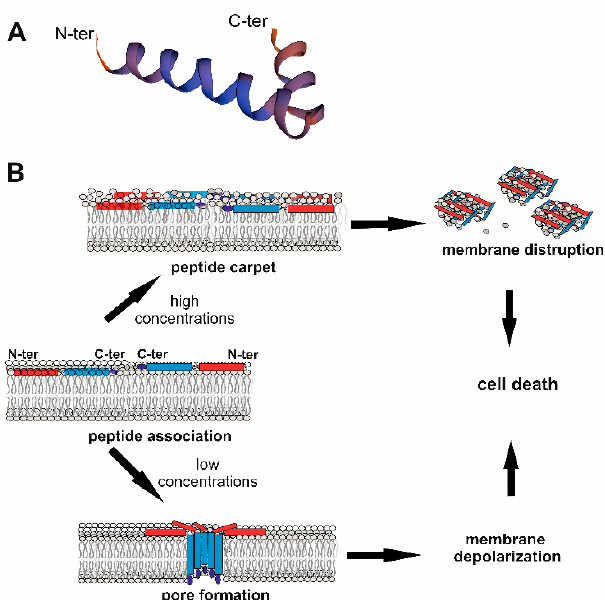
Figure 2. Cecropin (Cec) structure and mechanisms of action against bacteria. ( A ) Structure of the mature 35 aa B. mori Q53 Cec B natural variant [53] obtained using SWISS-MODEL (Available online: https: // swissmodel.expasy.org / ), showing N- and C-terminal α -helices linked through a flexible hinge region. ( B ) Model of action against bacteria. Cecs associate with the bacterial membrane, with the long axes of the α − helical domains parallel to the lipid bilayer surface. Polar residues interact with the lipid phosphates; non-polar residues bury in the hydrophobic core of the membrane. At high concentrations (upper part), Cecs form a carpet-like structure with detergent-like properties, disrupting membranes. At lower concentrations (lower part), Cecs form pores, which a ff ect the cellular electrolyte balance, causing bacterial death [85]. The pore is formed of di ff erent Cec molecules organized as oligomers, with C-terminal hydrophobic domains submerged into the phospholipidic hydrophobic chains [86]. The red rectangle represents the N-terminal helix, the blue one the C-terminal helix; the dark blue ellipse indicates the C-terminal amidated residue.